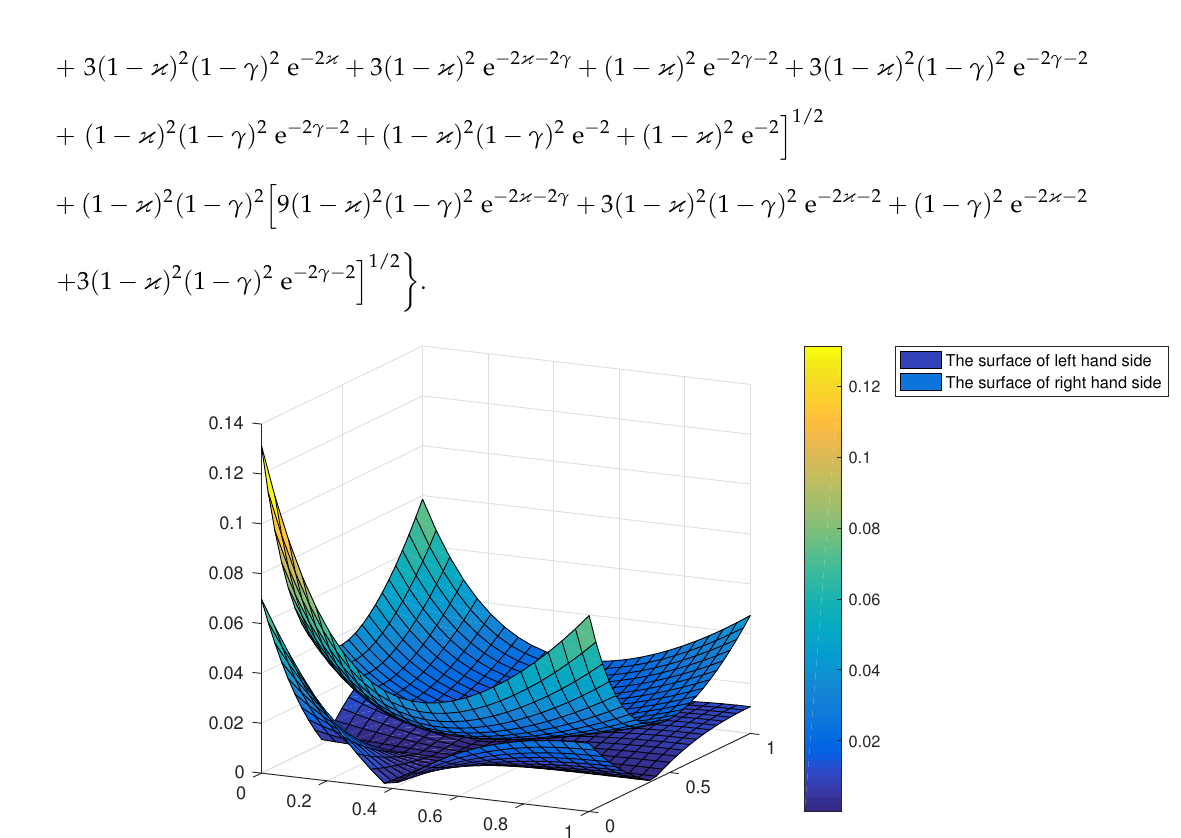
Figure 3. The image description for Theorem